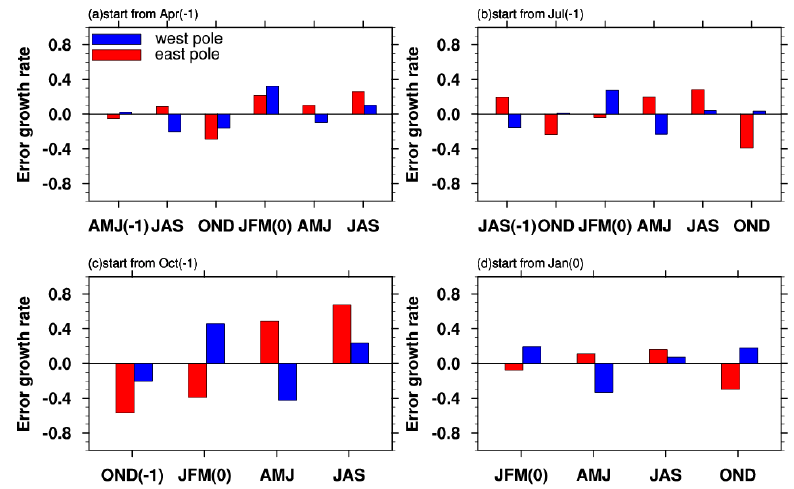
Figure 9. Ensemble mean of the growth rate for SST errors over the east and west poles induced by type-1 initial errors (histograms), with the start month being ( a ) April (-1), ( b ) July (-1), ( c ) October (-1) and ( d ) January (0).